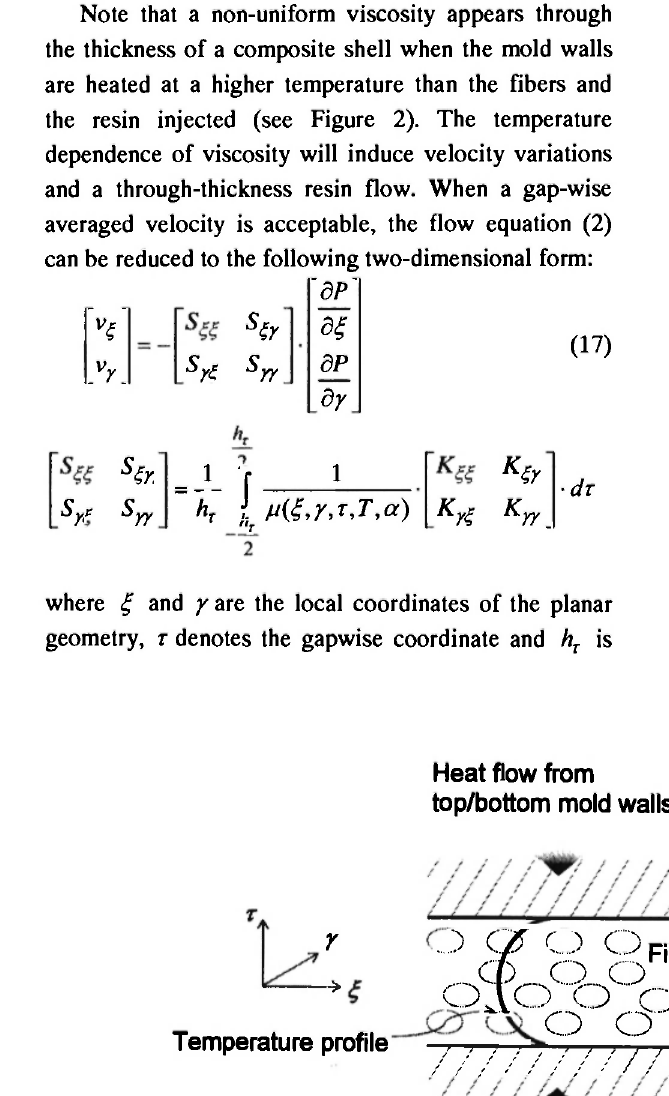
Fig. 2: Cross-section of the mold cavity showing the three-dimensional heat and fluid flows. The trough-thickness temperature profile results in variable resin viscosity and transverse fluid